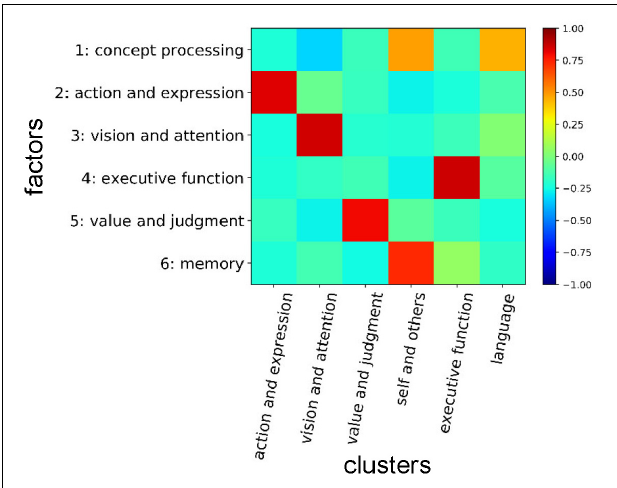
FIGURE 10 | Correspondences between cognitive clusters and factors. Correlation coefficients between NMF basis vectors for the factors and presence/absence vectors of cognitive functions for the clusters are shown. In the presence/absence vectors, the presences and absences in the cluster were assigned to ‘1’ and ‘0’,